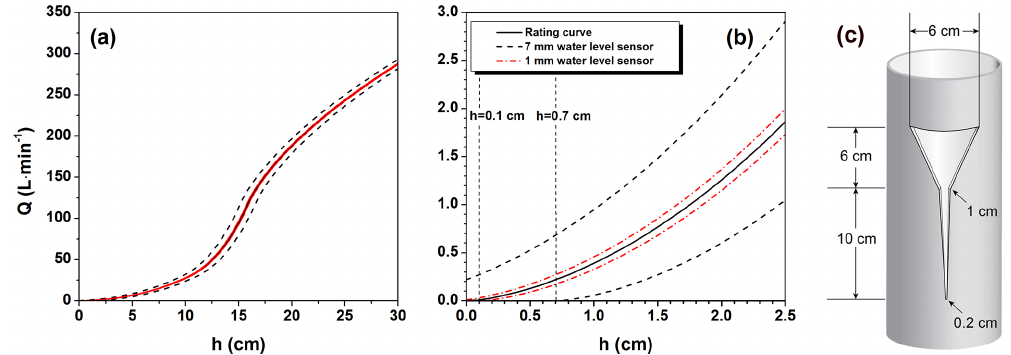
Figure 2. (a) Rating curve for the UBeTube configuration shown in Fig. 1, with c = 0 . 95; (b) the low flow ( < 3Lmin − 1 ) characteristic of the instrument; and (c) schematic showing the slot geometry. The black dashed lines in (a) and (b) show the expectedmeasurement error due to a ± 0.7cm water level measurement error within the tube, whereas the red dashed lines show the expectedmeasurement error due to a ± 0.1cm water level measurement error.